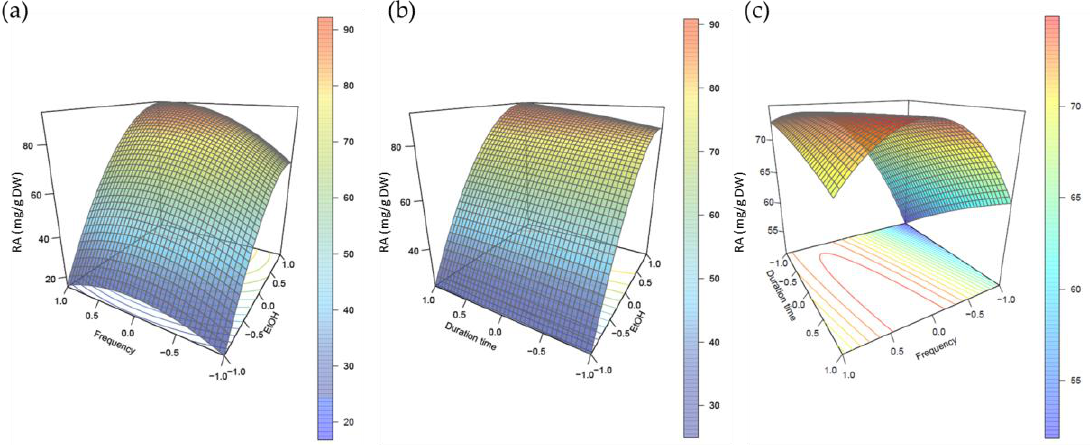
Figure 3. Predicted surface response plots of the RA extraction yield as a function of ( a ) ultrasound frequency and ethanol concentration, ( b ) extraction duration and ethanol concentration, and ( c ) extraction duration and ultrasound frequency.